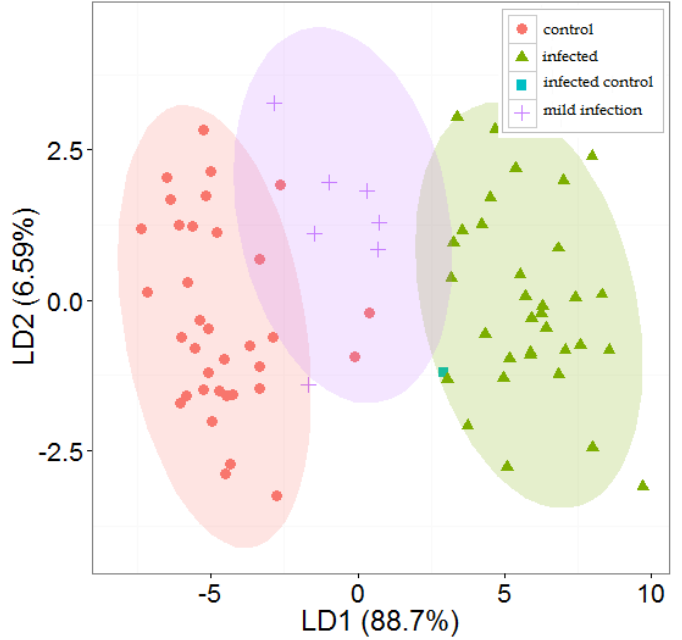
Figure 8. Predictive model based on LDA with 50% data as a testing set (there are three groups marked with a 95% confidence ellipse: control, mild infection and